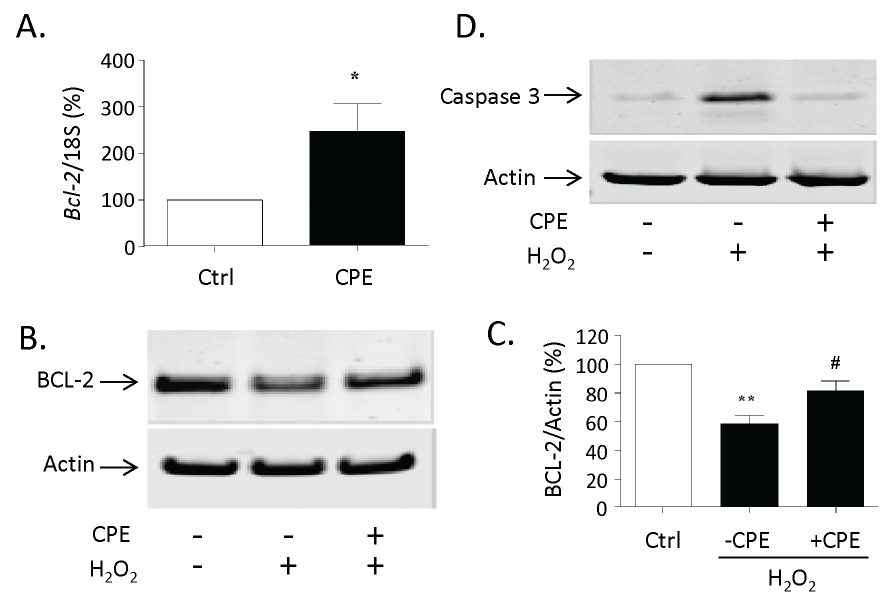
Figure 6. Neuroprotection by CPE involves BCL-2 and Caspase-3. A) Bar graph showing the quantification by qRT-PCR of Bcl-2 mRNA in primary cultured rat hippocampal neurons after treatment with 0.4 m M CPE for 3 h. Data is normalized against 18S RNA and presented as a % compared to untreated control (Ctrl) cells, (t-test, n=3, *p , 0.05). B) Representative Western blot analysis of BCL-2 protein in primary cultured hippocampal neurons, pretreated with 0.4 m M CPE for 24 h and subsequently challenged or not with H 2 O 2 for 24 h. Actin was also analyzed and served as an internal control for protein load. C) Bar graphs showing the quantification of BCL-2 protein normalized to Actin and expressed as a % compared to untreated control (Ctrl) cells. Note that CPE significantly inhibited the H 2 O 2 -induced decrease in BCL-2 protein in primary cultured hippocampal neurons, (t-test, n=4, ** p , 0.01 compared to Ctrl; # p , 0.05 compared to H 2 O 2 treated only cells) D) Western blot analysis of cleaved caspase-3 in primary cultured hippocampal neurons pretreated with 0.4 m M CPE for 24 h and subsequently challenged or not with H 2 O 2 for 24 h. Note that the H 2 O 2 -induced activation of caspase-3 is blocked by CPE. Western blot is representative of 2 independent experiments.